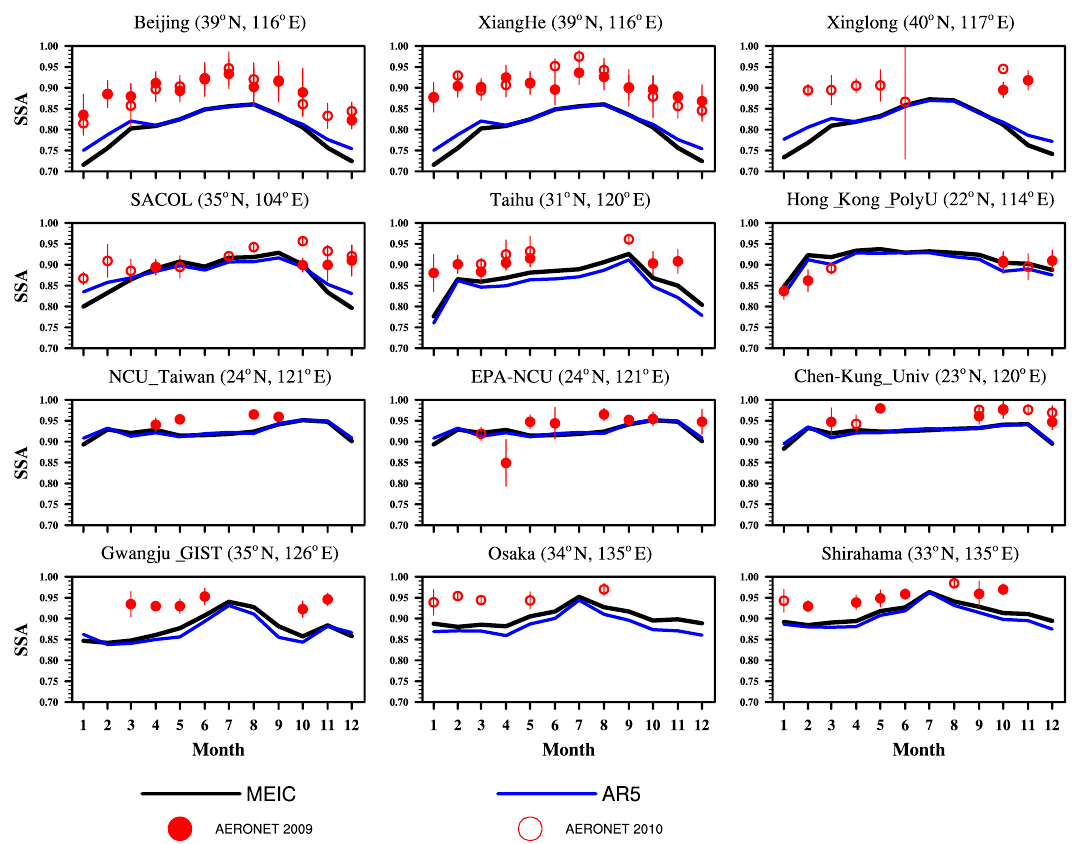
Figure 6. The seasonal variation of SSAs simulated by CAM5-MAM3 using the MEIC emission and the AR5 emission for the year 2009 and observed by AERONET (red solid circles for the year 2009 and hollow circles for the year 2010) at 12 AERONET sites in and around China. Error bars stand for 1 standard deviations of the